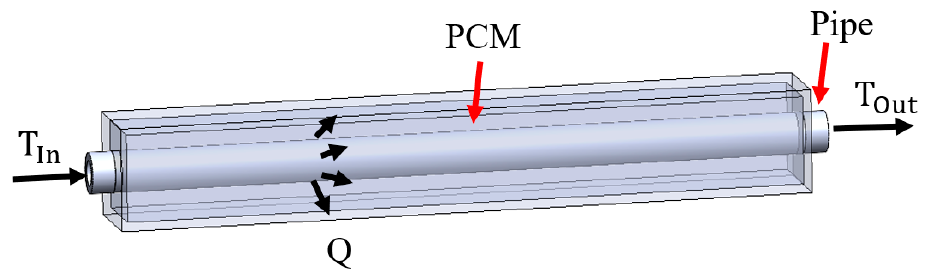
Figure 1. Analysis configuration.